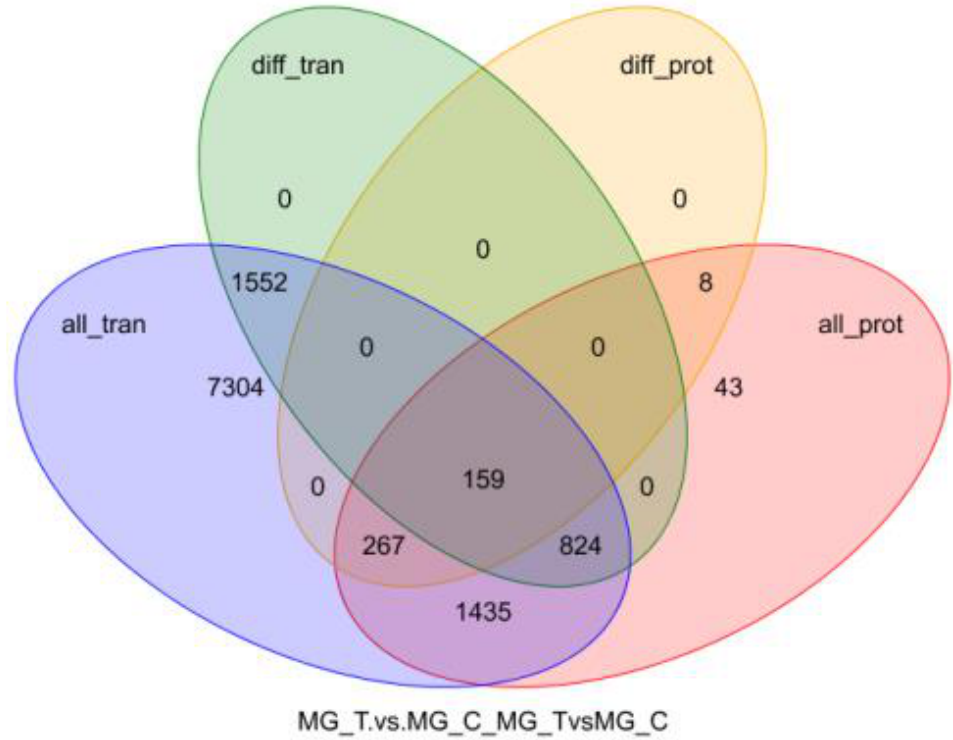
Figure 2. Venn diagram of transcriptome and proteome expression